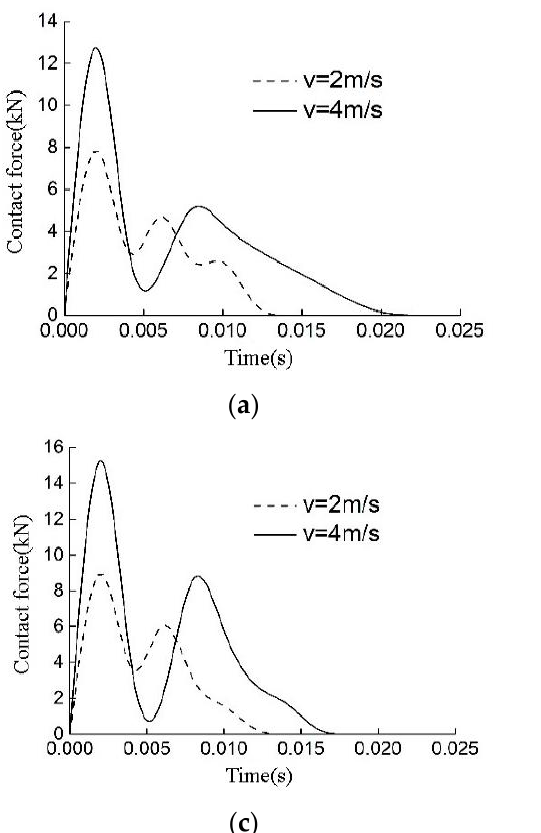
Figure 26. Relationship between peak contact force and axial pressure ratio: ( a ) axial compression ratio = 0.2; ( b ) axial compression ratio = 0.4; ( c ) axial compression ratio = 0.6; ( d ) axial compression ratio = 0.8.